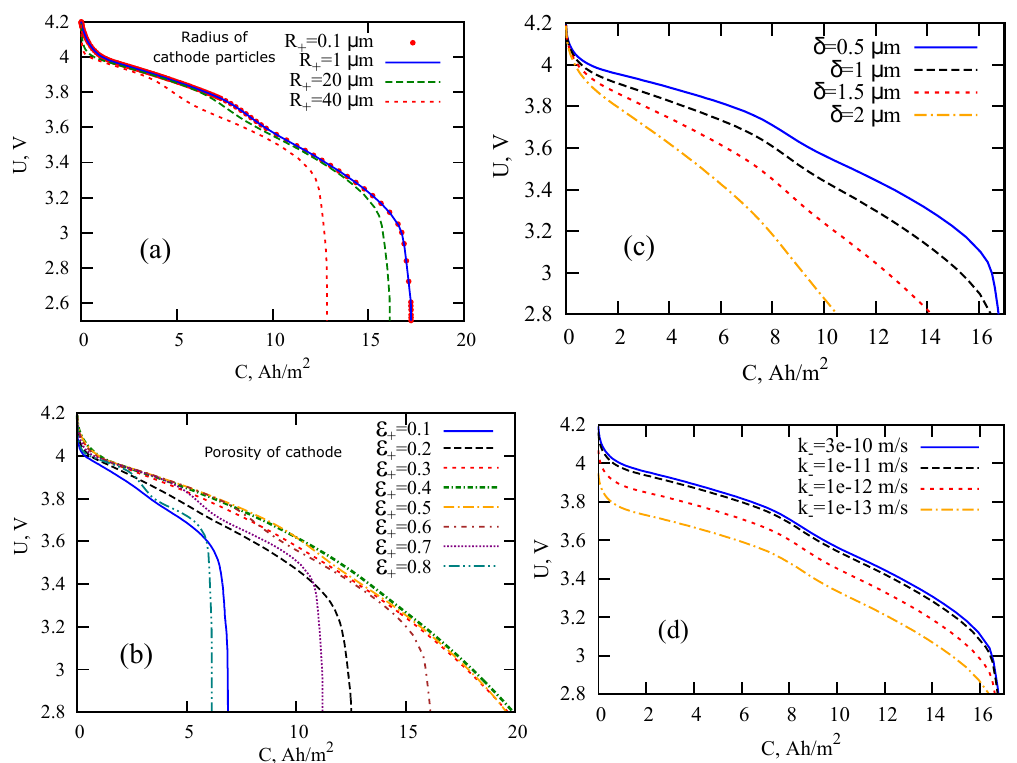
Figure 2. LIB discharge curves calculated within the SP model under normal diffusion conditions for the variation of different parameters: cathode particle radius ( a ), cathode porosity ( b ), solid-electrolyte interface (SEI) thickness ( c ), and electrochemical reaction rate in the anode ( d ). Other parameters are listed in Table 1, subdiffusion indexes are taken equal to